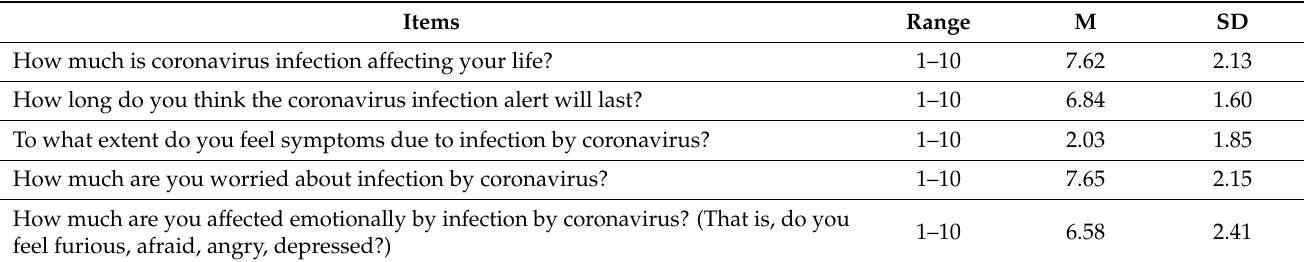
Table 1. Items measured by the Perception of Threat from COVID-19 instrument (by author). Items Range M